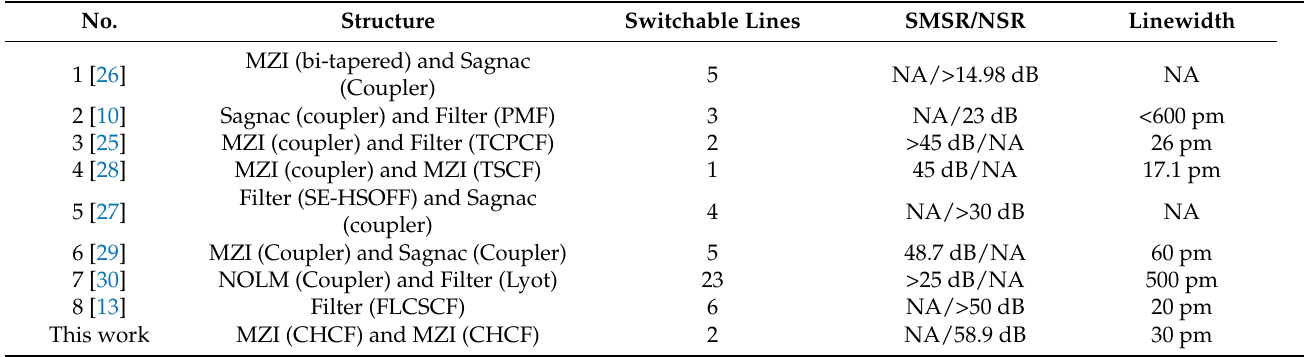
Table 4. Laser parameter comparison using recently published